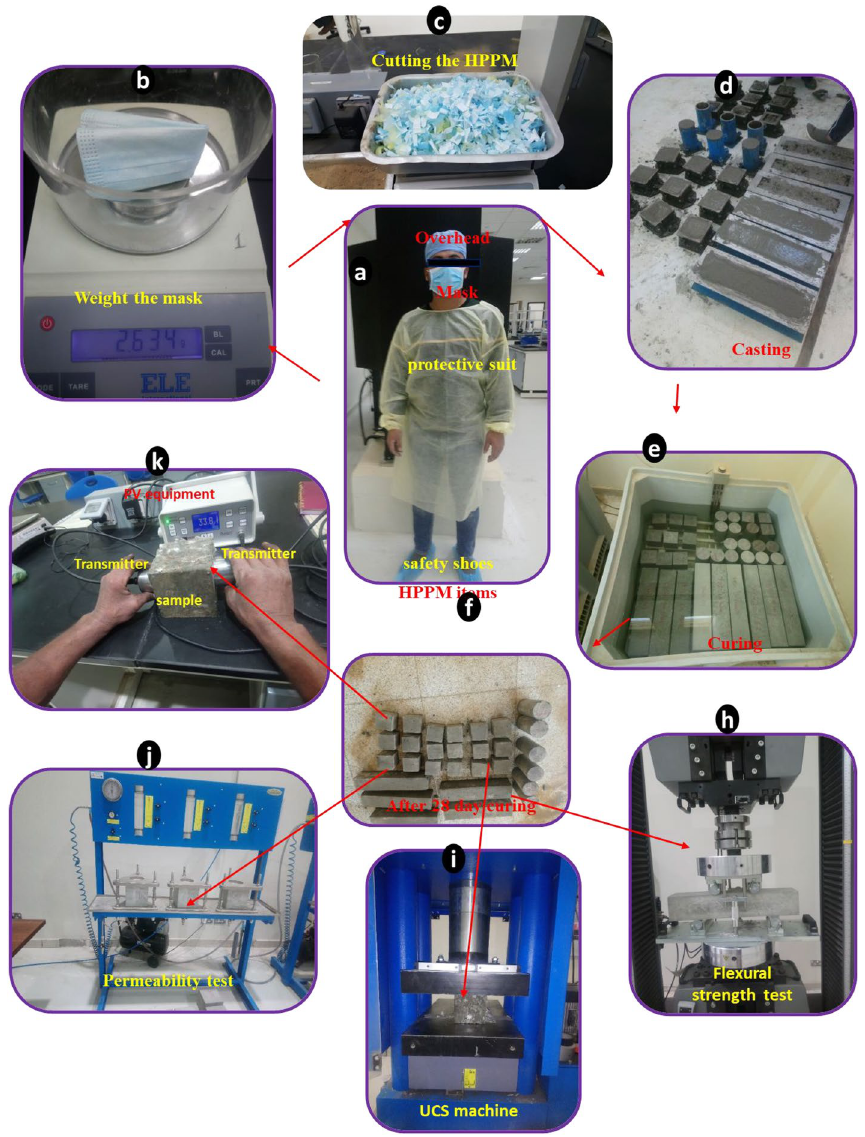
Figure 1. Experiment protocols, casting, and curing of the concrete with HPPM.